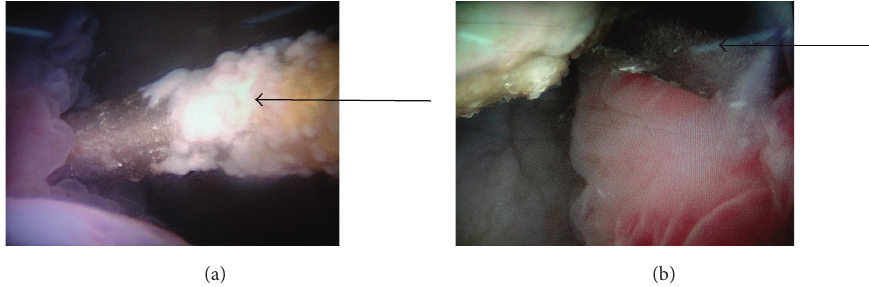
Figure 3: (a) Cystoscopic photograph showing the encrusted K-wire perforating through the right lateral wall of the bladder. (b) Cystoscopic photograph showing the K-wire exiting through the left lateral wall of the bladder.